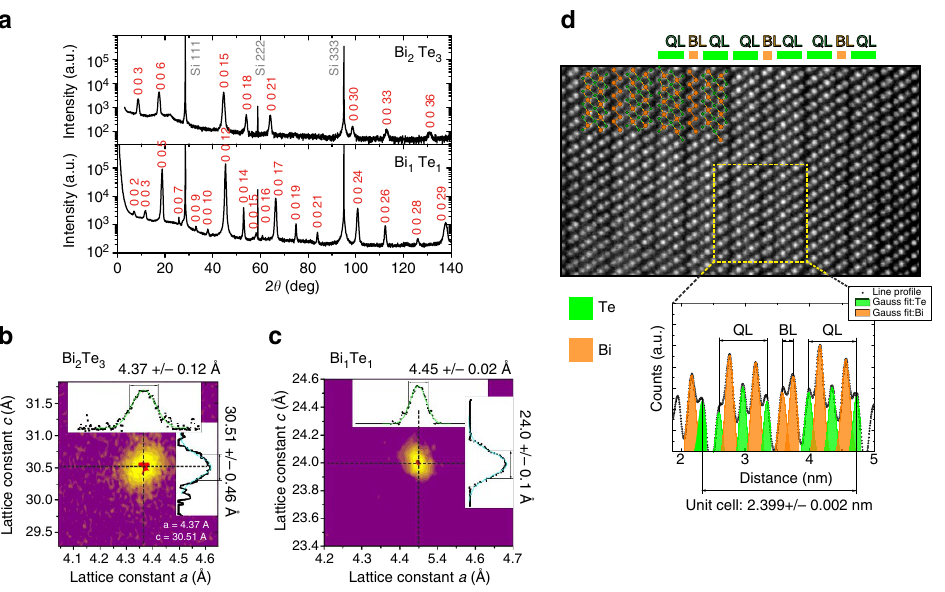
Figure 4 | Bulk characterization of Bi 1 Te 1 thin films. ( a ) Comparative XRD o /2 y scans for both Bi 2 Te 3 and Bi 1 Te 1 films averaged over the entire crystal ( b , c ). 2D reciprocal space maps obtained around the (1,0, (cid:2) 1,20) reflection for Bi 2 Te 3 ( b ) and the (1,0, (cid:2) 1,16) reflection for Bi 1 Te 1 ( c ) with derived lattice constants a and c from Gaussian fits. ( d ) Local STEM image of a 39-nm-thick Bi 1 Te 1 film confirming the high bulk crystalline quality. The contrast in the image scales with the atomic number squared ( Z 2 ), that is, bright ¼ Bi, darker ¼ Te. QLs and Bi BLs separated by van der Waals gaps can be identified. The yellow frame marks the region over which the line profile below is measured while averaging in the vertical direction. QLs and BLs are denoted and Bi and Te atomic layers are displayed by orange and green columns,